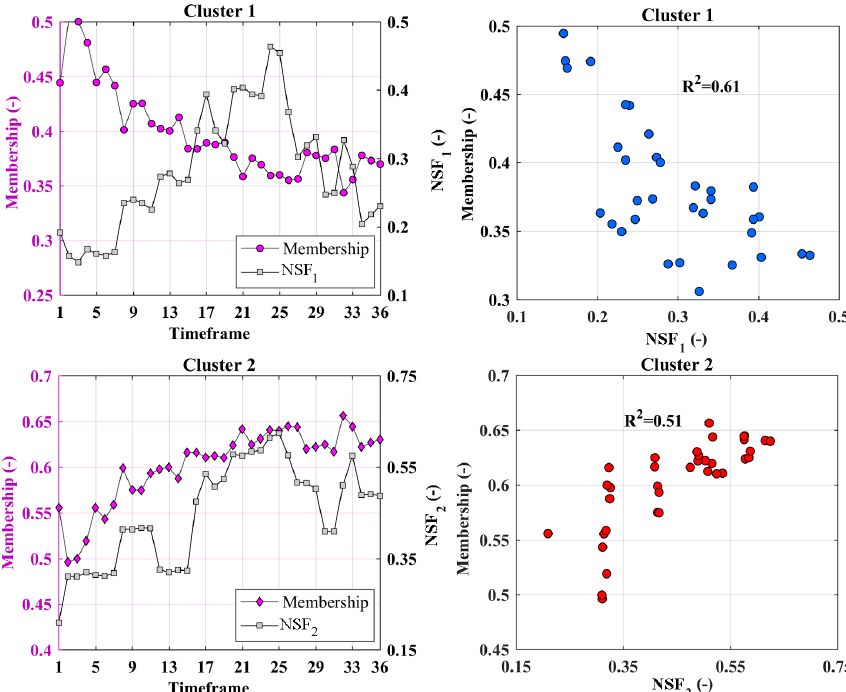
Figure 3. The procedure of attributing changes in membership degrees to changes in streamflow characteristics. The left column shows the co- evolution of membership degrees and normalized streamflow features (i.e., NSF 1 and NSF 2 ). The right column measures the correspondence between changes in membership degrees and normalized streamflow features through percentage of described variance quantified using R 2 . Red and blue dots show the positive and negative dependencies, respectively.